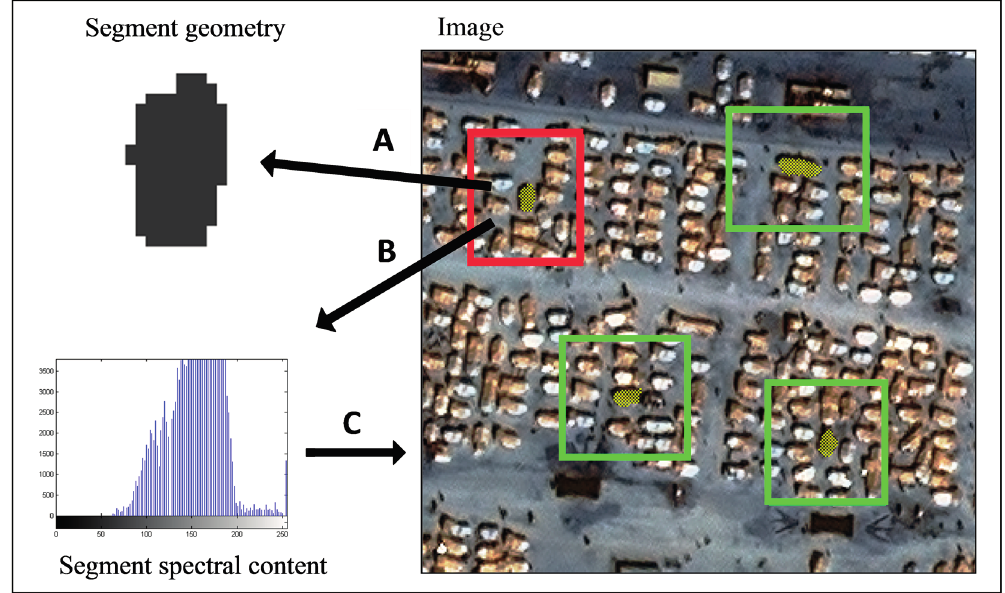
Figure 2. The rationale behind the proposed method. Segment geometry is commonly provided via digitizing and used to drive a parameter search process (Arrow A ) for segment generation. Reference segment spectral content (Arrow B ), which is implicitly